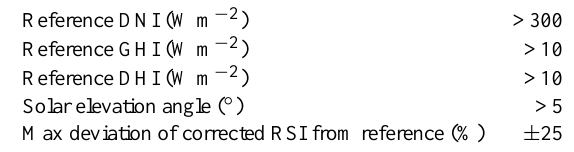
Table 3. RSR2, RSP4G and Twin-RSI sampling rates (Wilbert et al., 2015). Rotation frequency GHI DHI DNI Calculated from GHI, DHI and solar Twin RSI 1 / (30s) alternating for both 1 / s Shadowband correction position as 1min average with sensors averaged with previous correction for DHI drift value Averaged for each rotation Averaged for each rotation Calculated once per minute Calculated every second from 1s GHI as average of two rotations samples. Averaged every 60s